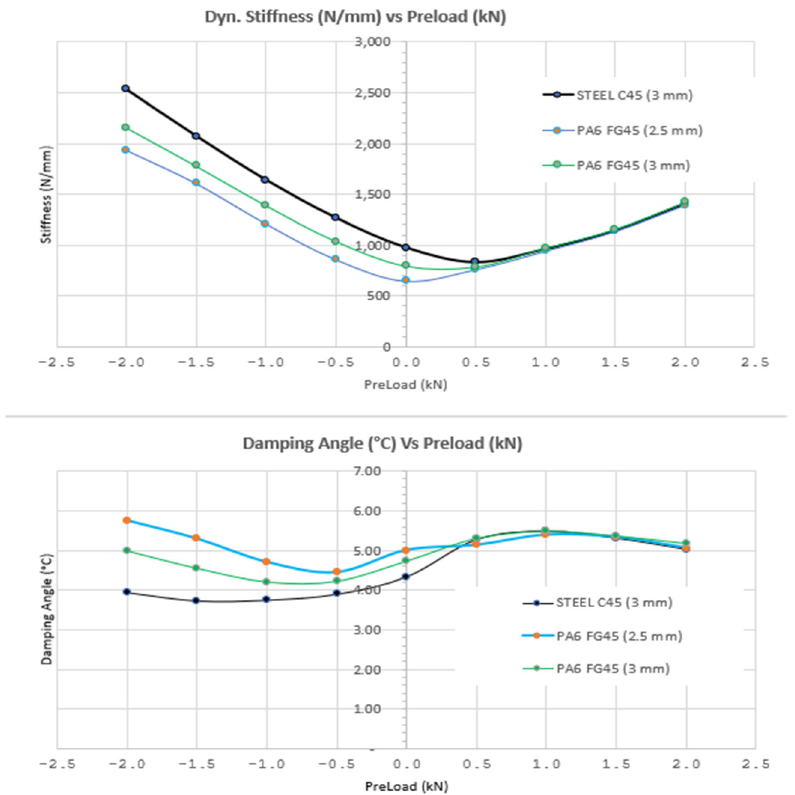
Figure 11. Diagrams of the Axial Dynamic Test (Pre-FAT). Stiffness (top) and damping (bottom) of the CFRTP and steel prior to the Fatigue Test.